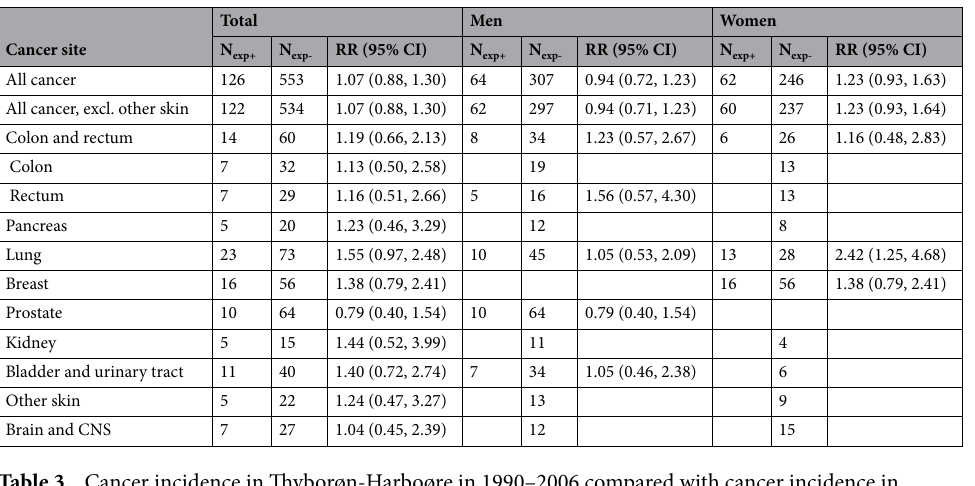
Table 3. Cancer incidence in Thyborøn-Harboøre in 1990–2006 compared with cancer incidence in geographical control group. Number of cancer cases in Thyborøn-Harboøre (N exp+ ), number of cancer cases in Holmsland-Hanstholm (N exp- ), rate ratio (RR), and 95% confidence interval (CI). RR adjusted for running age in 5-years age group, 5-year calendar period of follow-up time, and for total also for sex. Only cancer sites with 5 + cancer cases. Blank cell means cancer site not relevant in that sex, or less than 5 observed